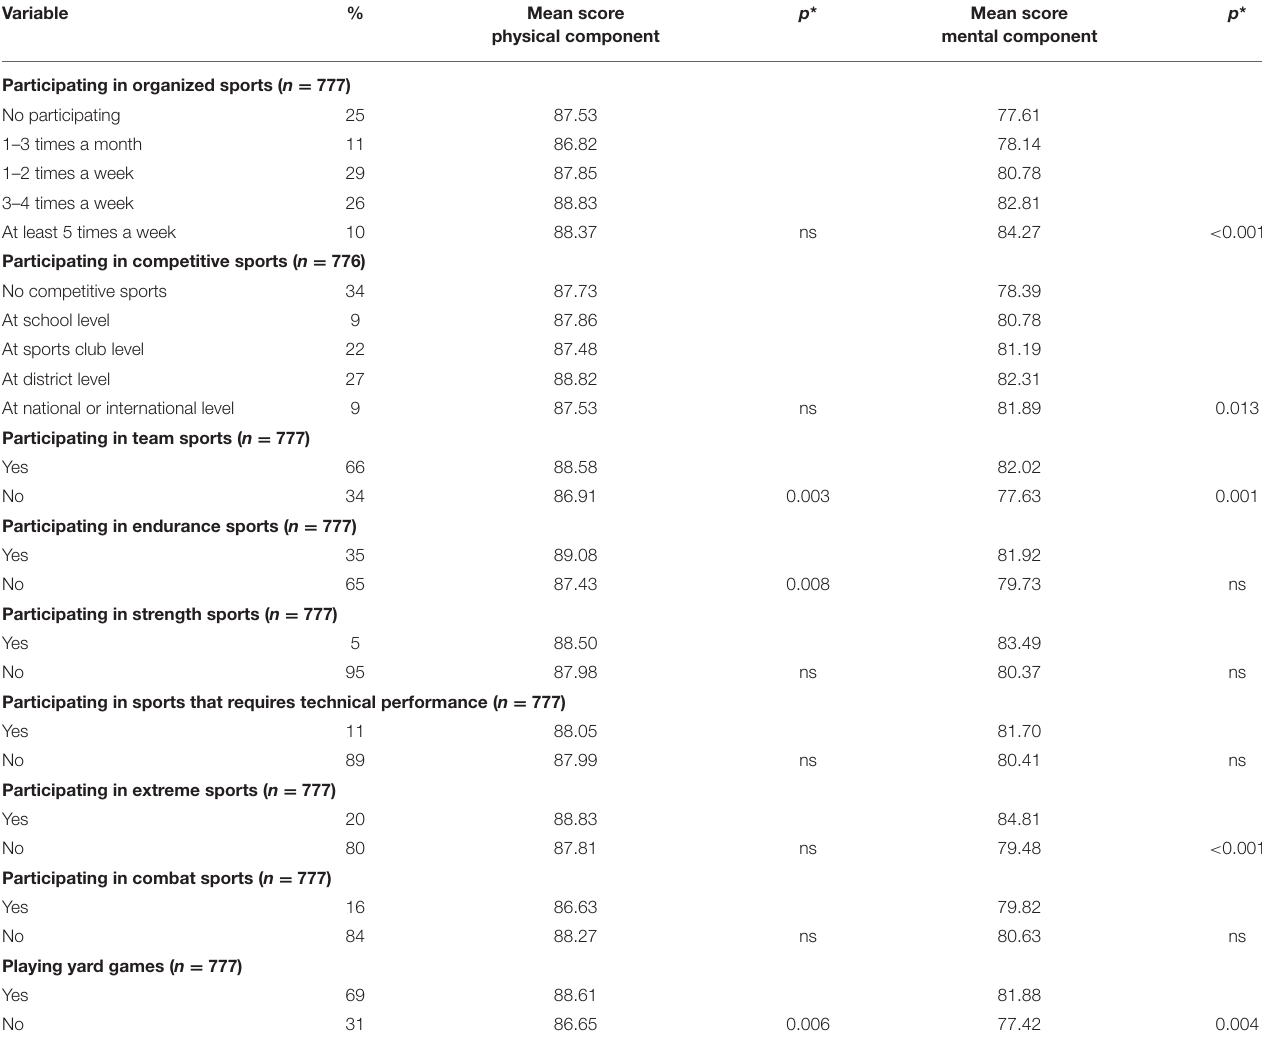
TABLE 2 | Mean scores of the physical and mental components of HRQoL according to sports participation at the age of 12 years. Variable % Mean score physical